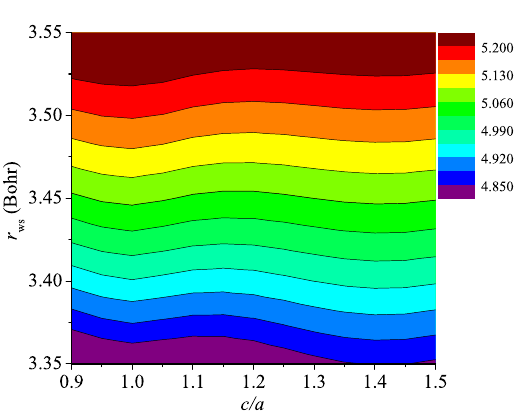
Figure 3. Free energy ( = − + − F E TS F TS , in unit of Ry) change with respect to the Wigner-Seitz el el vib mag radius ( r ws ) and c / a of Pu using the equilibrium μ Pu . Results are shown for 650 K ( a ), 700 K ( b ), 750 K ( c ), and 800 K ( d ), respectively. The two minima at c / a = 1.414 and c / a = 1 correspond to the δ and ε phases.